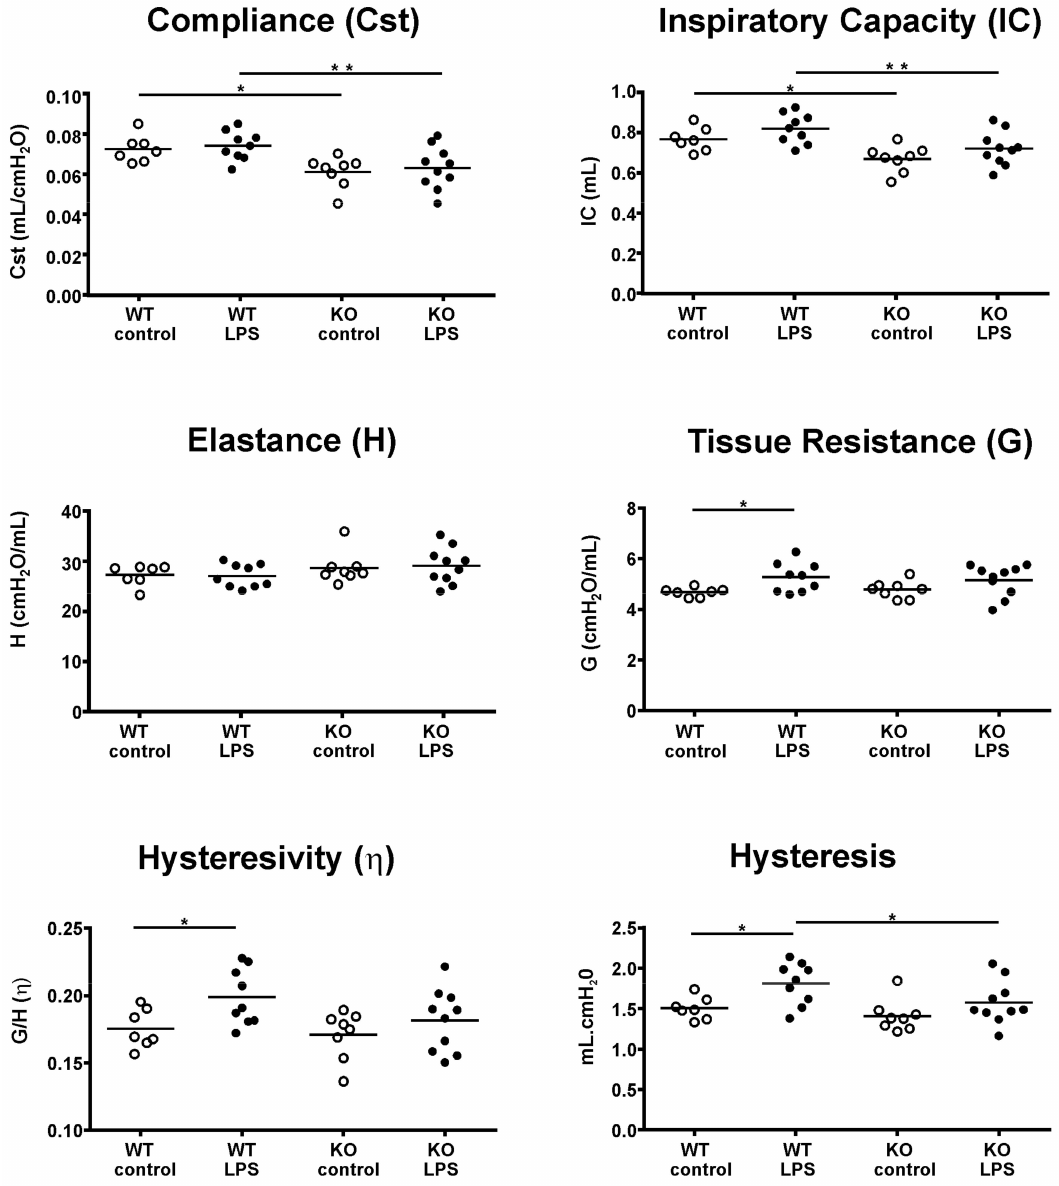
Figure 1. Lung function analysis. Pulmonary function and micromechanics were assessed at a positive end-expiratory pressure (PEEP) value of 3 cmH 2 O with a mouse FlexiVent (SCIREQ) ventilator in wild-type (WT) and knock-out (KO) mice with and without acute lung injury (ALI). Each data point represents one animal; means are expressed by horizontal bars; lines indicate statistically significant di ff erences between groups (* p < 0.05, ** p <